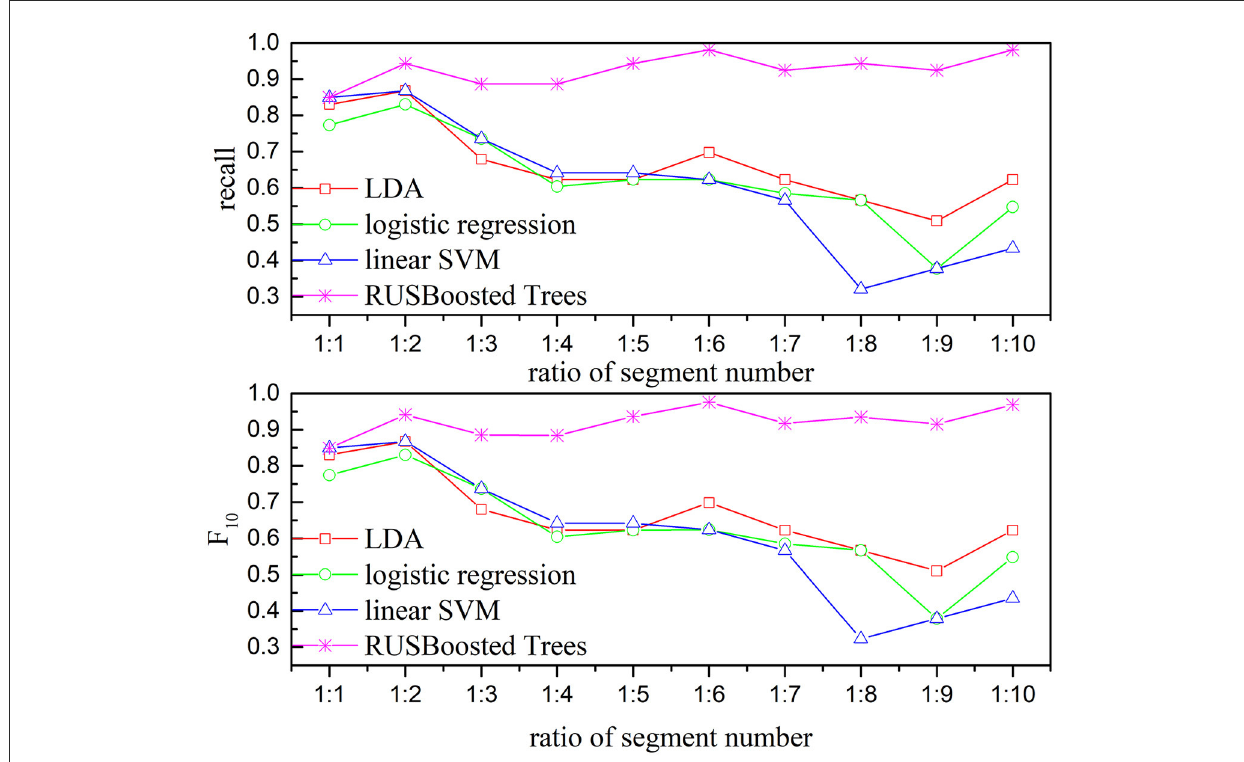
FIGURE14 Relationship between the performance-based kappa and F 10 and the ratio of segments number for subject 1 (the number of k-complex is fixed as 263, and the segment number of non–k-complex is multiple of the number of k-complex from 1 to 10).